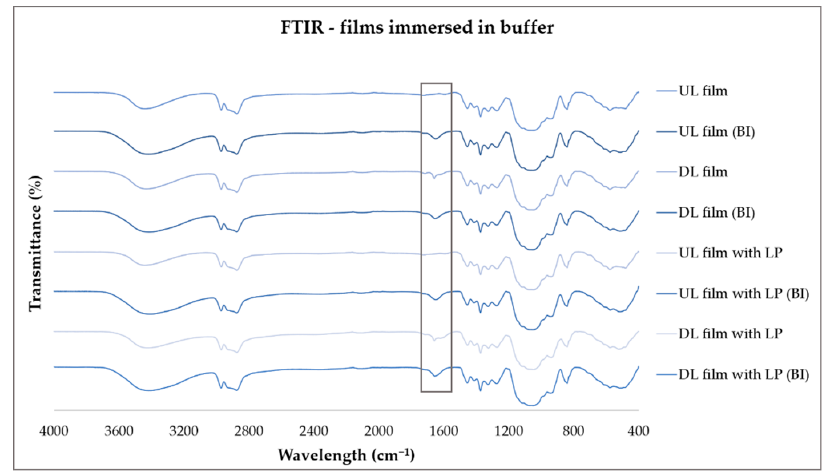
Figure 12. FTIR spectra of dried and buffer-immersed (BI) dried unloaded and drug-loaded films with and without liver powder.